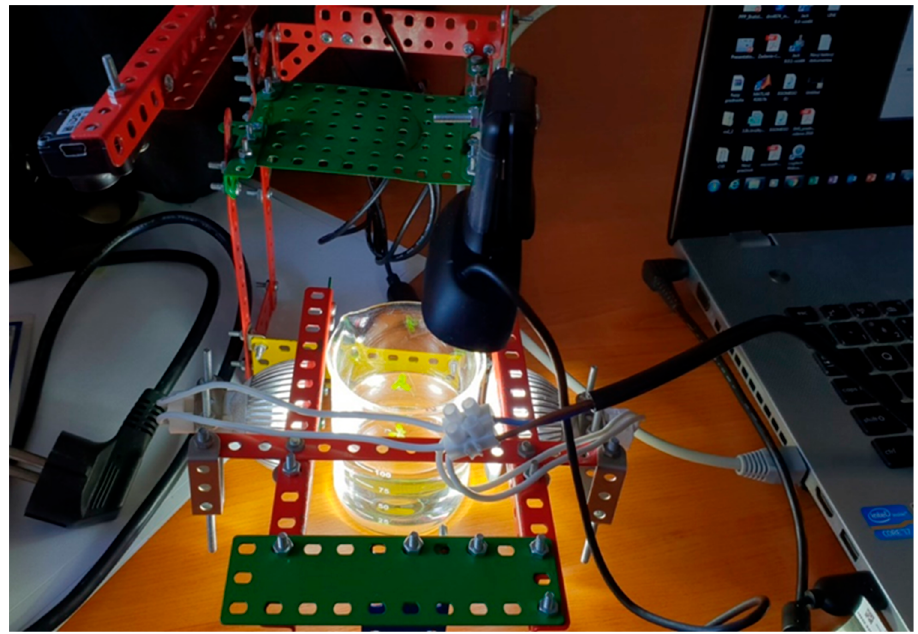
Figure 1. Visual system for the Lemna minor bioassay evaluation. Figure 1 Visual system for the Lemna minor bioassay evaluation.